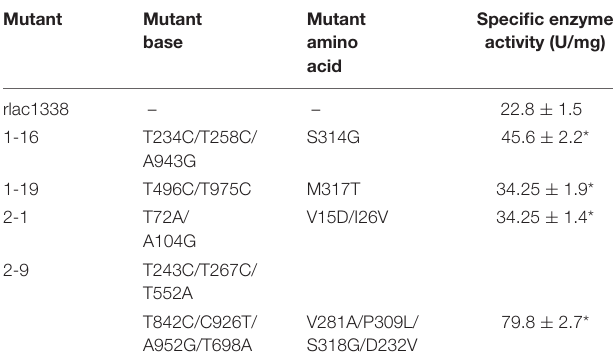
TABLE 1 | Nucleotide substitution and amino acid changes of the mutant